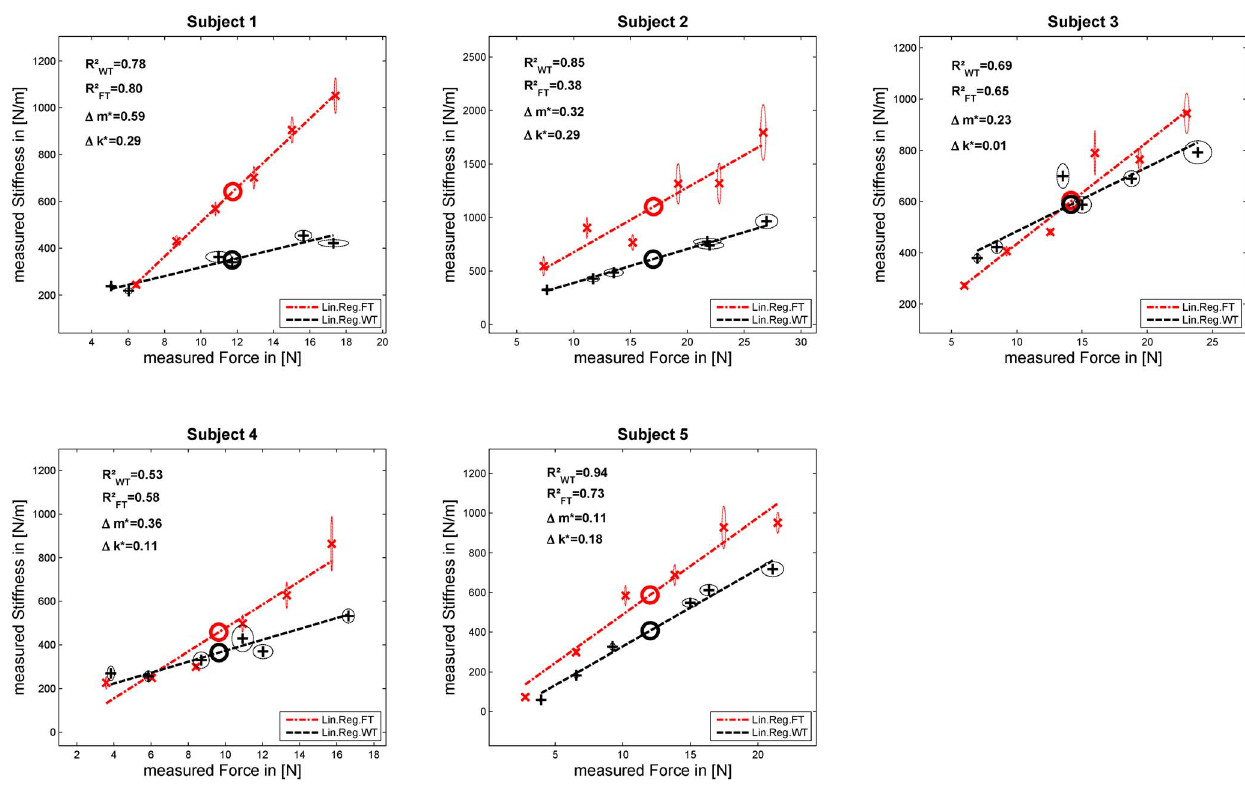
Figure 5. Results Experiment 1. Subjects doing the WT first without a cuff.